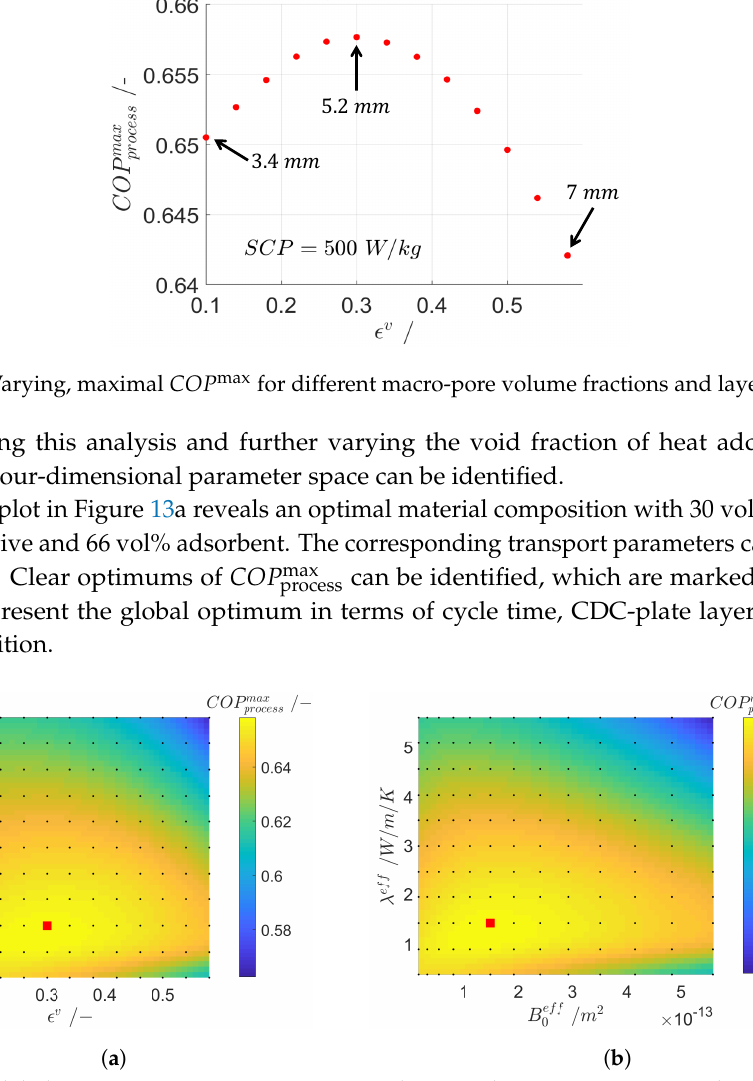
Figure 13. Global optimum concerning process and material parameters. For each composition, cycle time and plate layer thickness are optimal. The squares represent the global optimum, where additionally the composition of the CDC-plate is optimal. ( a ) COP max process with respect to volume ratios of heat additive, macro-pores and adsorbent. ( b ) COP max process with respect to effecitve heat conductivity and